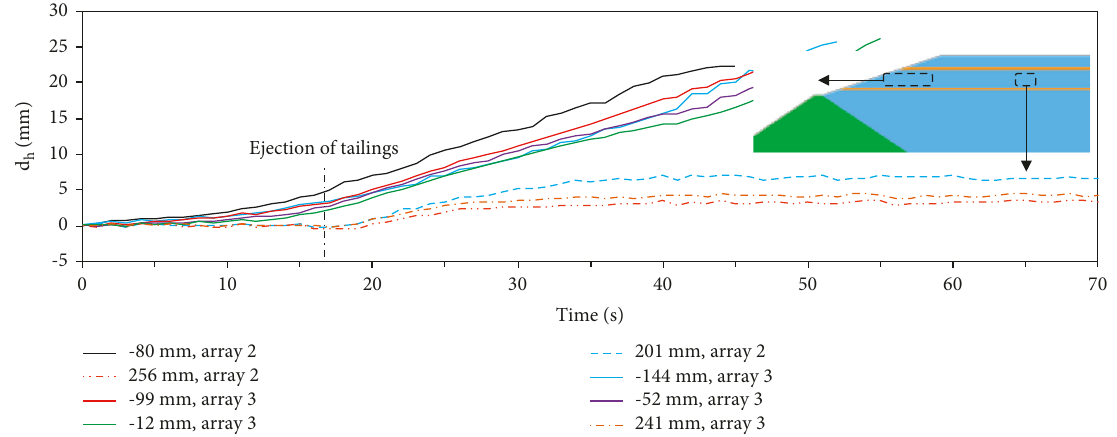
Figure 16: Evolutions of horizontal displacements of the trace markers in arrays 2 and 3 with